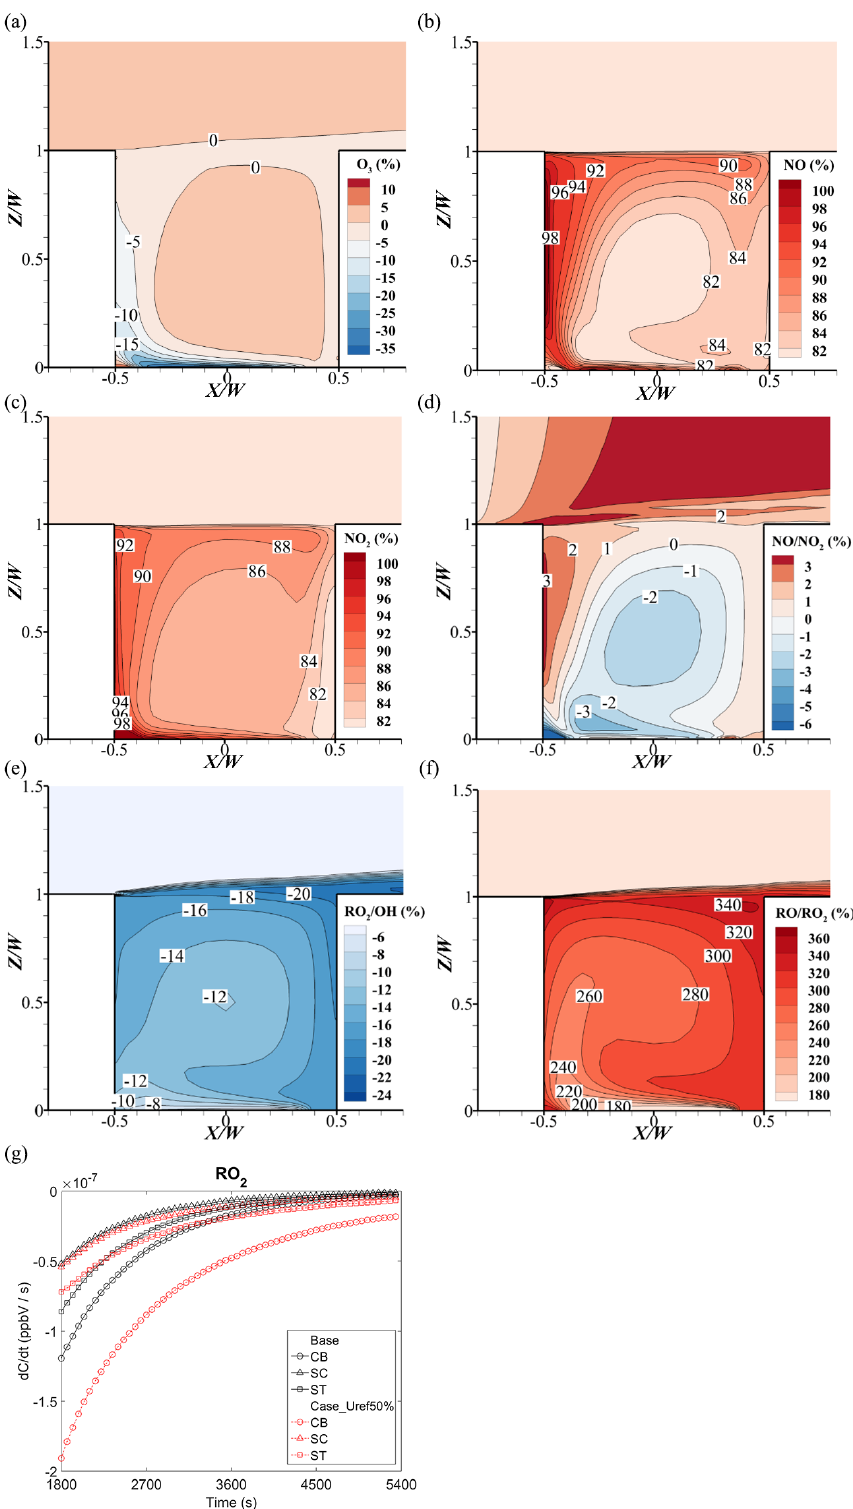
Figure 18. Change rate of (a) O 3 , (b) NO, (c) NO 2 , (d) NO / NO 2 , (e) RO 2 / OH, and (f) RO / RO 2 at t = 5400s. (g) Time series of the reaction rate of RO 2 ( dRO 2 ) of d t